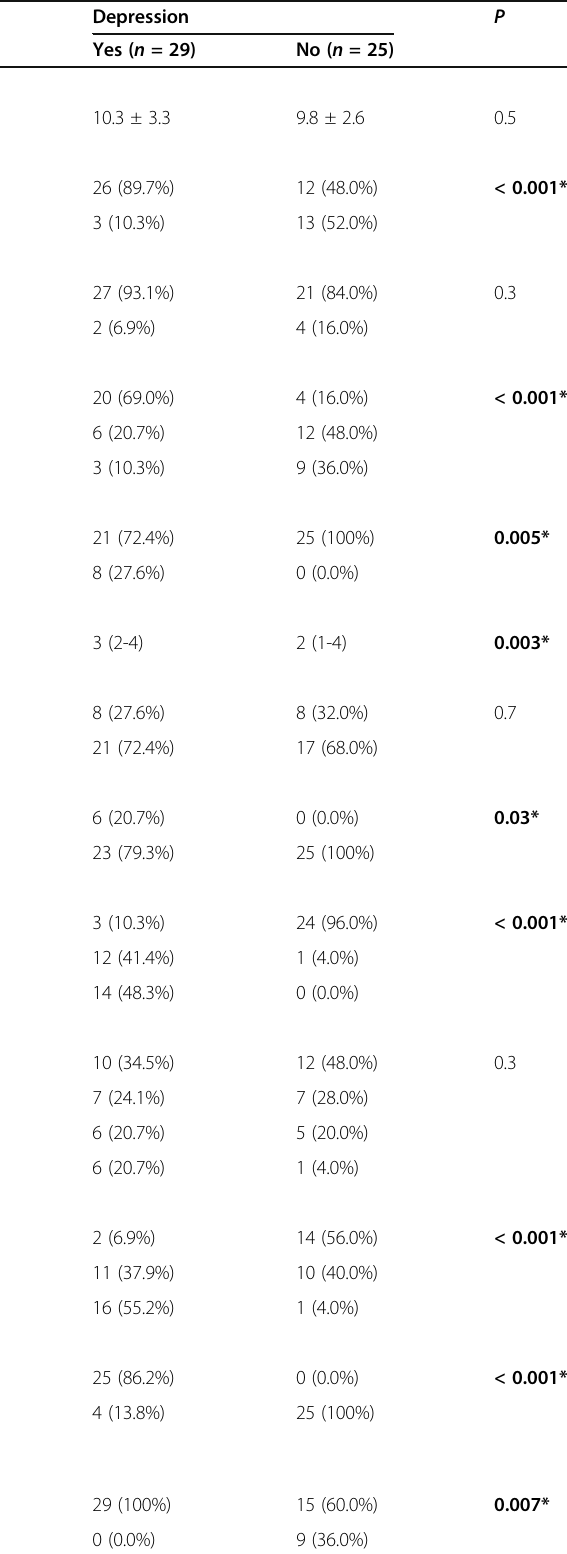
Table 3 Association between depression and other characteristics in mothers of ADHD children